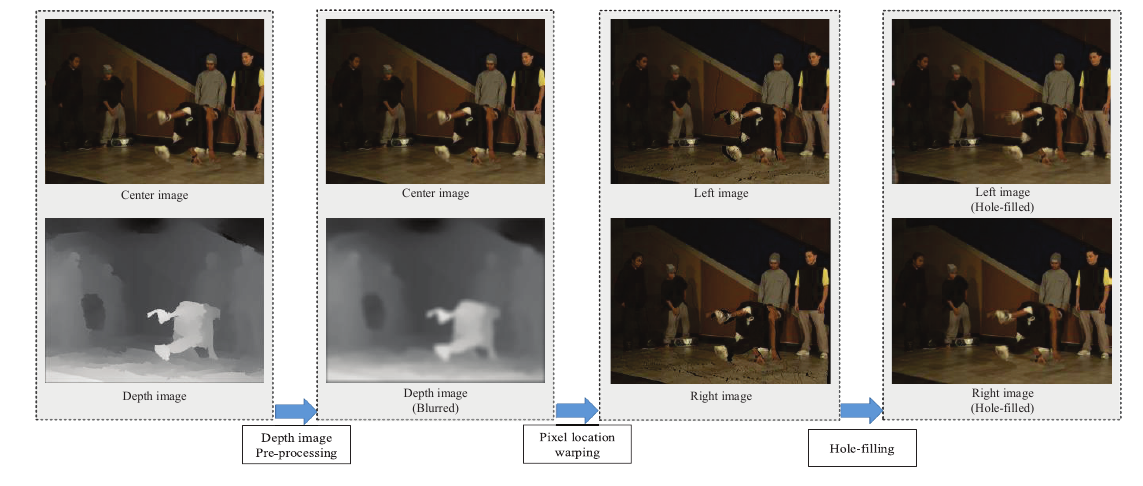
Figure 2. Overall process of the DIBR